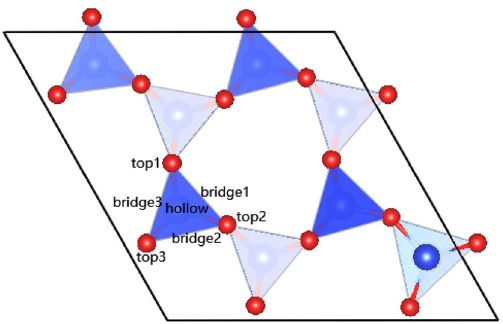
Figure 2. The adsorption site on the (001) surface of montmorillonite.